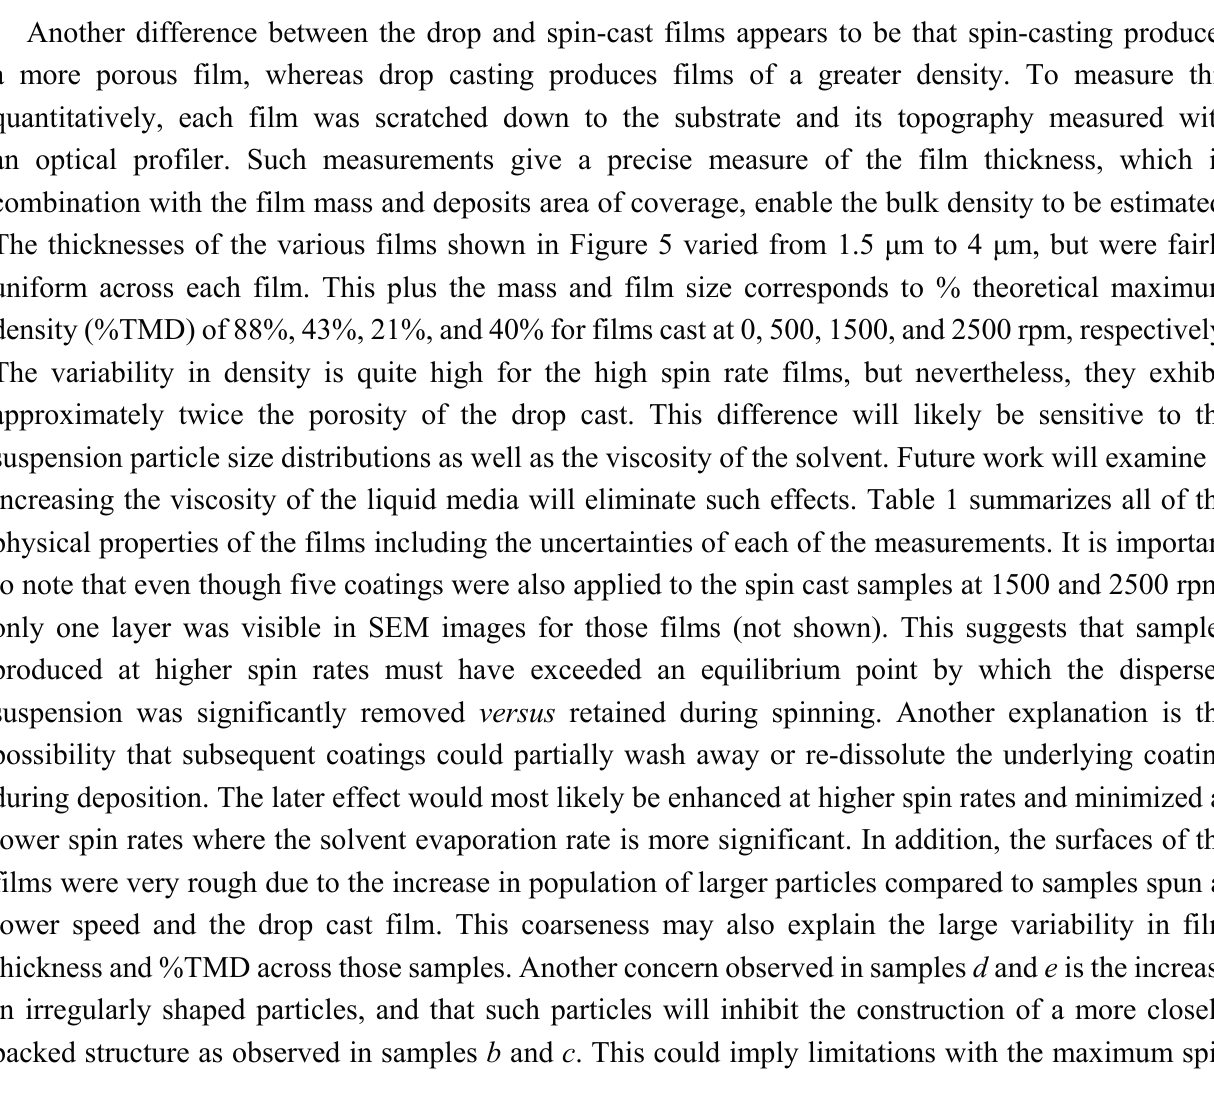
Figure 6. Apparent particle size distributions of the spin-cast films depicted in Figure 5, as obtained from electron microscope images. These HI 3 O 8 particulate films were deposited at ~2% relative humidity from a sonicated suspension of the as received material in denatured ethanol at spin coat rates of 0 rpm (drop-cast), 500 rpm, 1500 rpm, and 2500